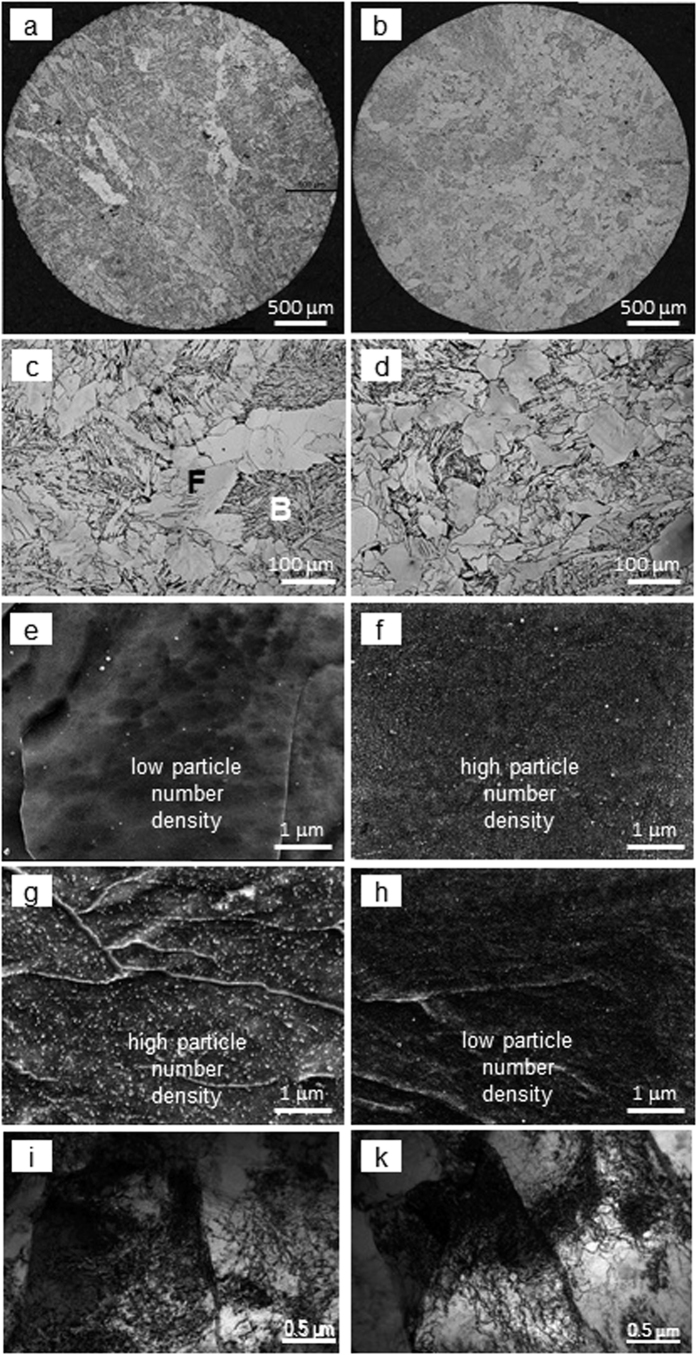
Optical images of the (a,b) whole samples used to measure the phase fractions and (c,d) selected areas showing ferrite-bainite microstructures (F is ferrite, B is bainite), SEM images of precipitates in (e,f) ferrite and (g,h) bainite, (i,k) TEM images of bainite for solidification rates of (a,c,e,g,i) 1 Cs−1 and (b,d,f,h,k) 30 Cs−1.